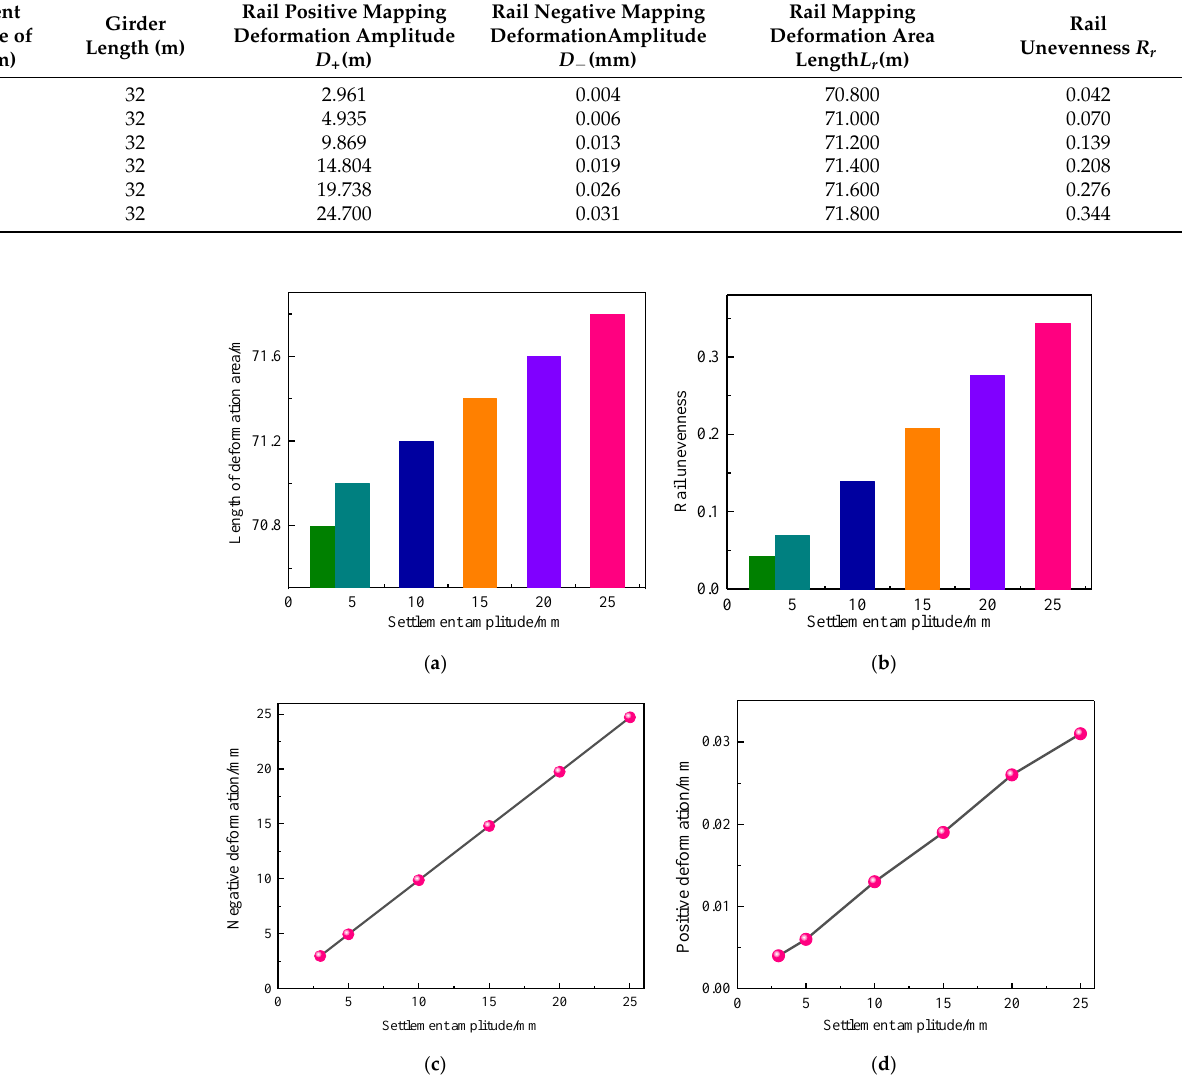
Figure 10. Relationship between rail mapping deformation amplitude, deformation area length and rail unevenness, and settlement amplitude of the bridge pier. ( a ) Length of the deformation area; ( b ) rail unevenness; ( c ) positive deformation; and ( d ) negative deformation.